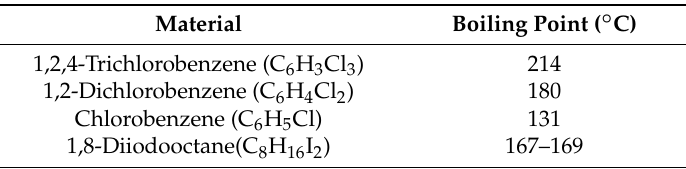
Figure 2. Molecular structure of ( a ) chlorobenzene (CB), ( b ) 1,2-dichlorobenzene (DCB), ( c ) 1,2,4- trichlorobenzene (TCB), ( d ) DIO ( e ) PTB7.